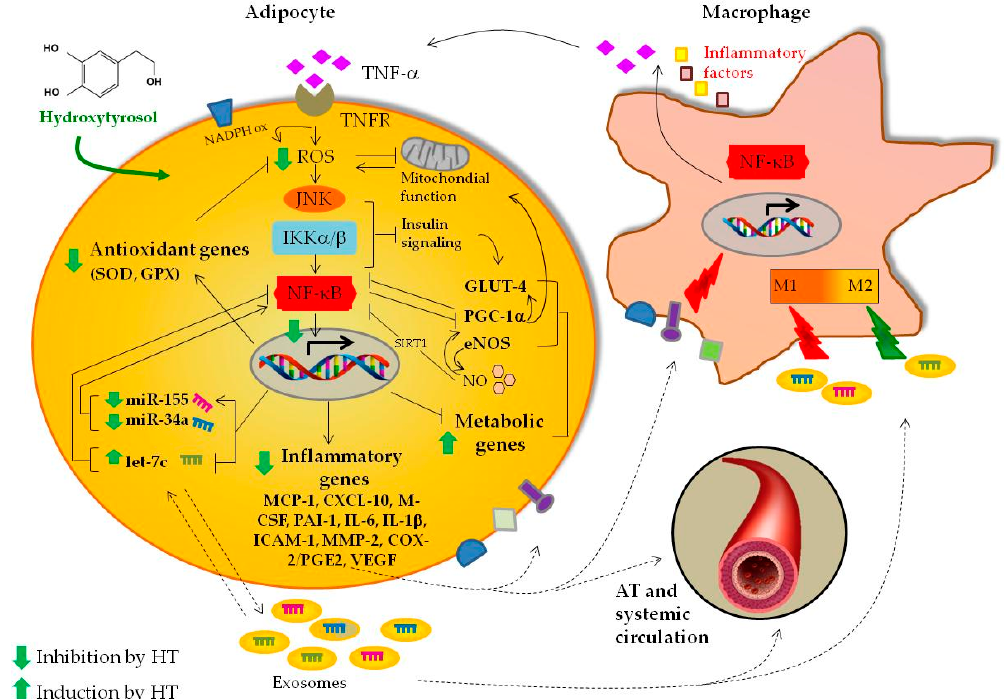
Figure 10. Schematic summary of the modulation by HT of TNF- α -induced gene and miRNA expression in adipocytes. Upon binding to the cognate receptor, TNF- α , which is mostly produced by the adipose tissue (AT) inflammatory macrophages (M1 polarized), triggers a cascade of signaling events involving the overproduction of ROS (by dysfunctional mitochondria and other sources such as NADPH oxidase), as well as the activation of MAPK and IKK / NF- κ B pathways, culminating in the upregulation of pro-inflammatory genes and miRNAs (miRs) including miR-155 and miR-34a, and the downregulation of anti-adipogenic metabolic genes (eNOS, PGC-1 α , GLUT-4), and anti-inflammatory miRs (let-7c). These deleterious gene expression changes may act in a paracrine and endocrine manner inducing adipocyte dysfunction as well as macrophage recruitment / inflammatory polarization (M1 phenotype). HT inhibits TNF- α -induced oxidative stress and NF- κ B activation, and ameliorates the pattern of gene and miRNA expression toward a potential anti-inflammatory, insulin-sensitizing and anti-adipogenic profile. See text for further details. The arrow indicates stimulation. The line indicates inhibition. JNK: c-Jun N-terminal kinase; MAPK: mitogen-activated protein kinase; NADPH ox: NADPH oxidase; TNFR: TNF- α receptor; IKK: I κ B kinase.